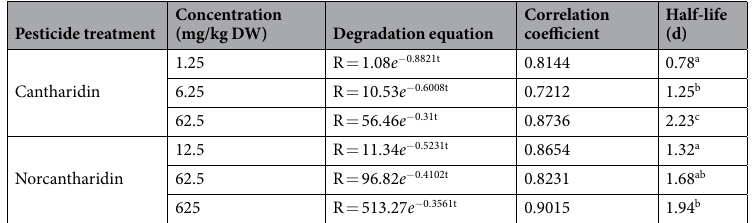
Table 2. Degradation dynamics data of cantharidin and norcantharidin at the recommended, five and fifty–fold doses in the soil. Data in the same column followed by the different letter are significant ( p ≤ 0.05).